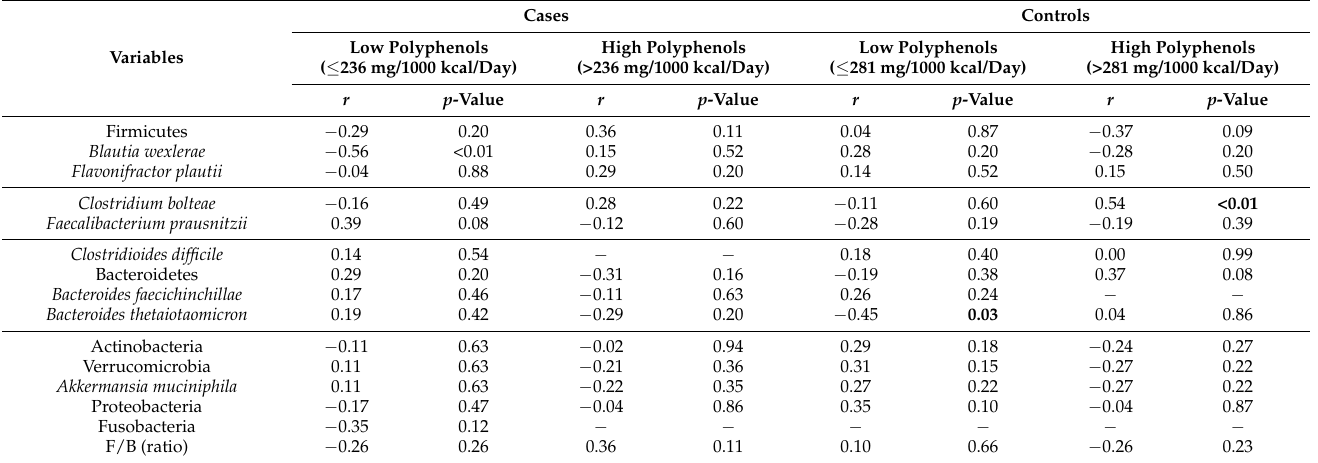
Table 3. Correlations between gut microbiota and dietary polyphenol intake across each